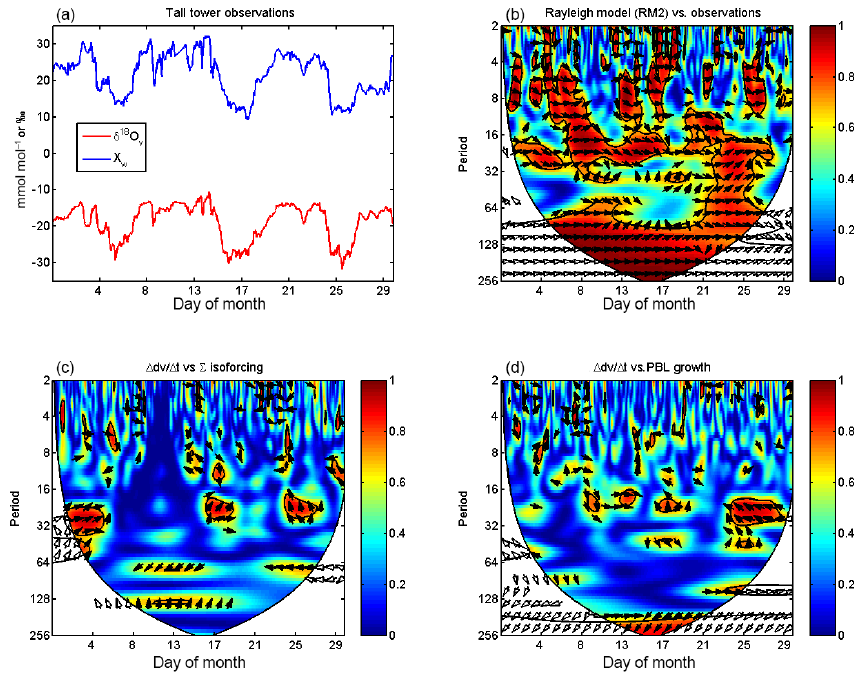
Figure 5. Wavelet coherence analysis of the oxygen isotope ratio of water vapor ( δ 18 O v ) for August 2010. Hourly observations of water vapor mixing ratio and oxygen isotope ratio from the tall tower 185m sample level (a) . Wavelet coherence of modeled oxygen isotope ratios using the Rayleigh model (described in the text) vs. the observations (b) . Wavelet coherence of time derivative of δ 18 O v vs. evaporation isoforcing integrated over the depth of the PBL (c) . Wavelet coherence of time derivative of δ 18 O v vs. PBL growth (d) . The color bar represents the local correlation coefficients in time–frequency space. The period is shown in hours. The black arrows represent the phase angle relationship between the variables. Arrows pointing east and west show signals that are in perfect phase and antiphase, respectively. Arrows pointing north show that variable 1 leads variable 2 (defined in figure panel titles) by a phase shift of 90